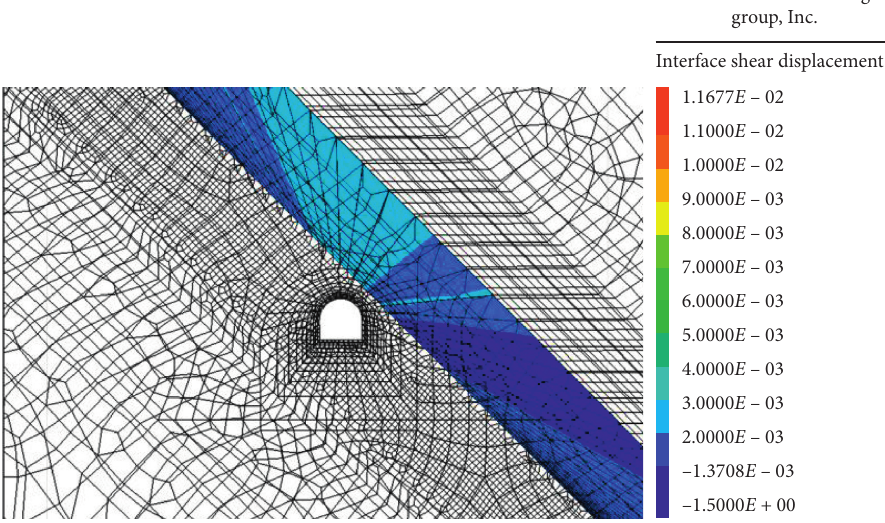
Figure 13: Nephogram of shear displacement on weak structural plane of roadway roof strata. Table 3: Statistical table of deformation index of surrounding rock of